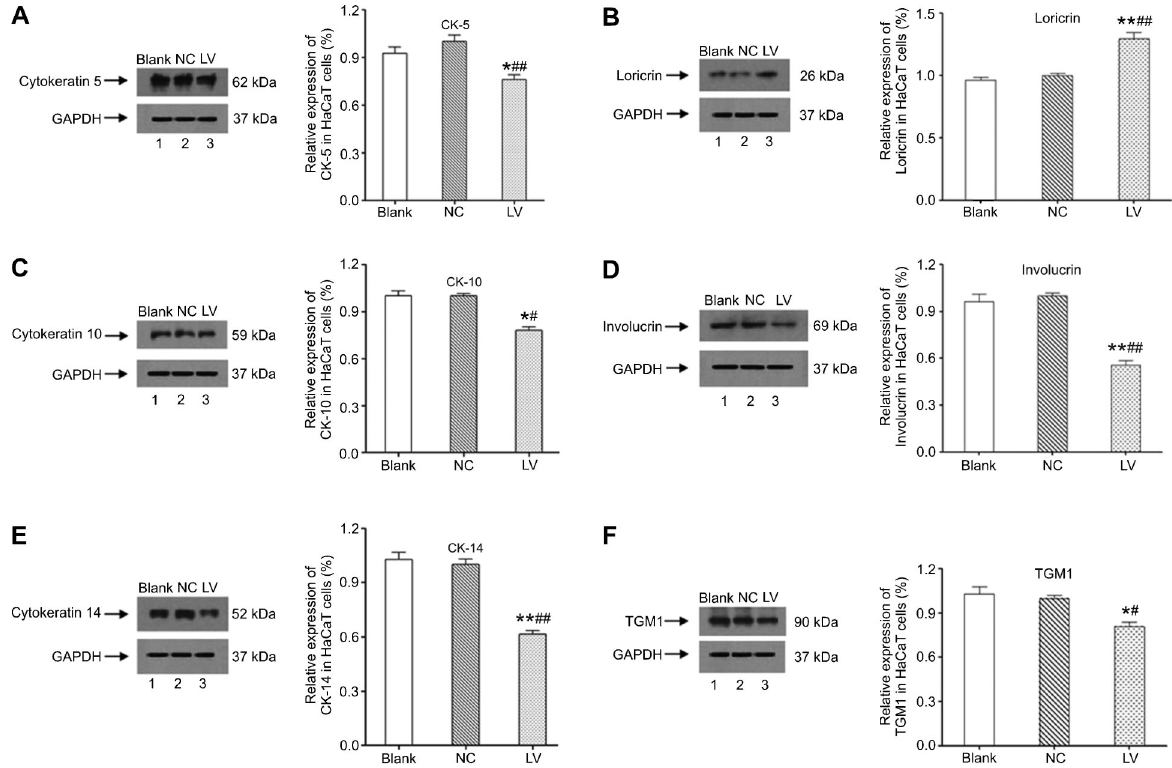
Figure 2. Western blotting detection for cytokeratin 5, 10, 14, and loricrin, involucrin, and transglutaminase-1 (TGM1) expression in normal human epidermal keratinocytes (NHEKs) after shRNA silencing. LV group: filaggrin-silenced cells; NC group: shRNA control cells; Blank group: noninfected cells. *P , 0.05, **P , 0.01 vs Blank group; # P , 0.05, ## P , 0.01 vs NC group (least significant difference